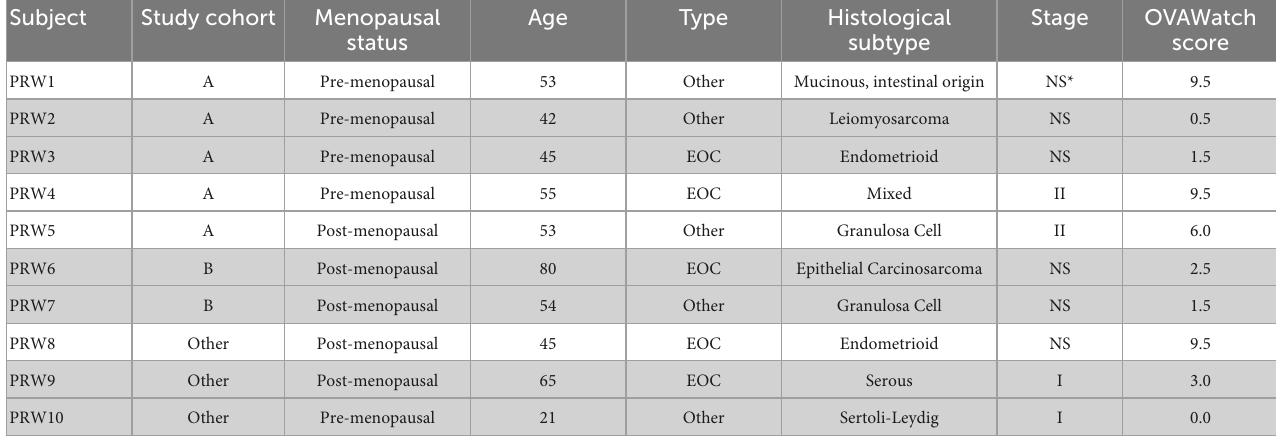
TABLE 4 OVAWatch score in prospective real-world (PRW) patients with malignancies.